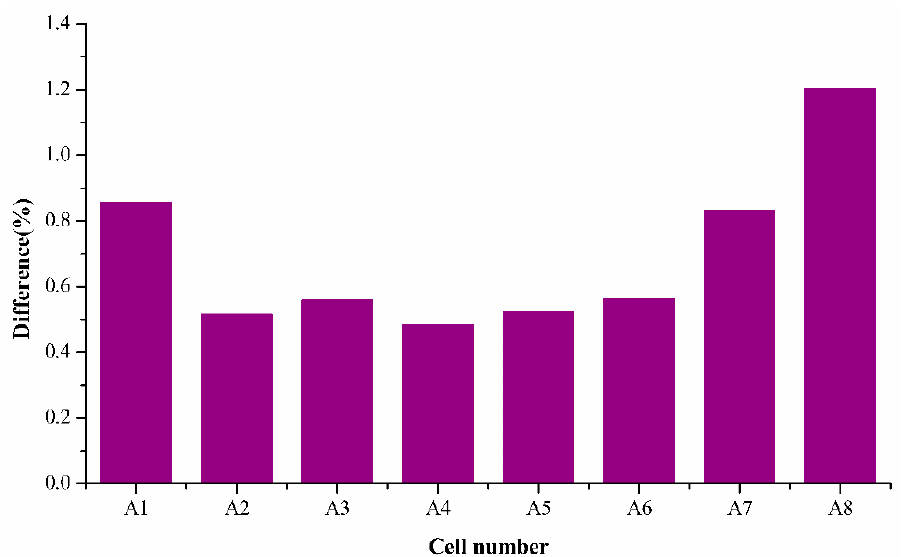
Figure 7. Mean difference comparison result using averaged K-value of each cell tested after the completion of the test at the respective charge–discharge cycles mentioned in Figure